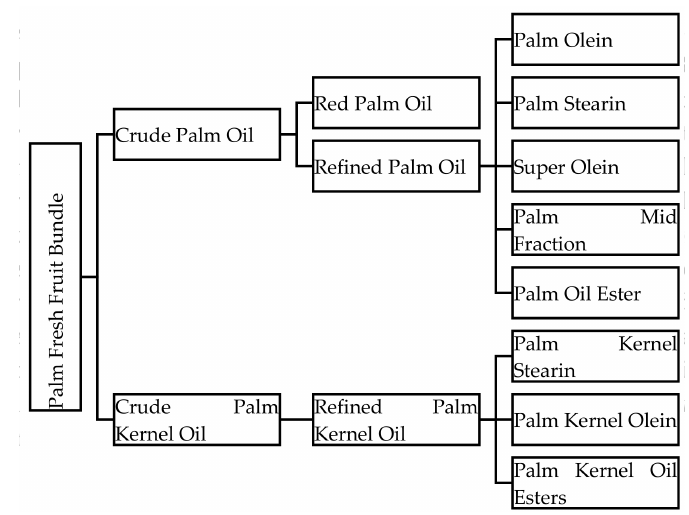
Figure 1. Overview of downstream products of palm oil and its